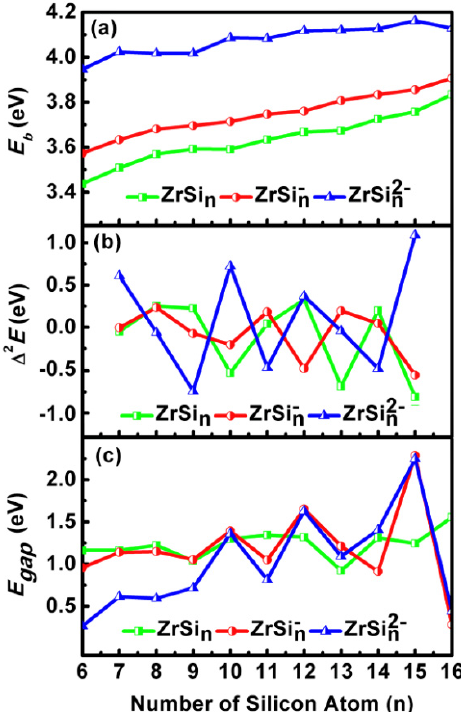
Figure 5. Size dependences of ( a ) average bonding energy ( E b ). ( b ) second energy difference ( ∆ 2 E ), and ( c ) HOMO-LUMO energy gap ( E gap ) for the ground state ZrSi n 0/-/2- ( n = 6–16)